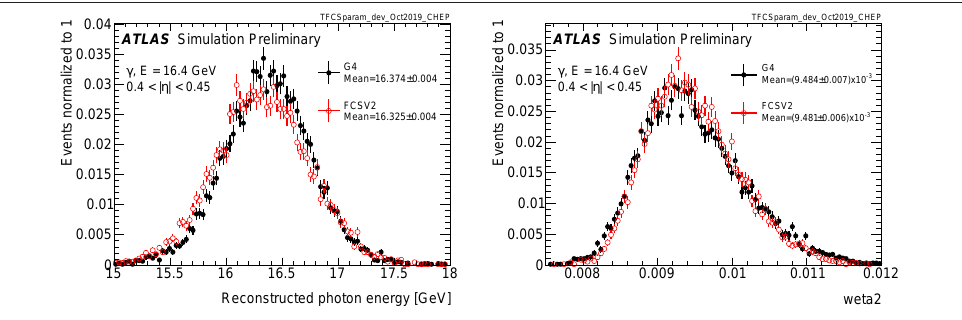
Figure 1. Energy and lateral shower width variable, weta2, for 16 GeV photons with full simulation (G4) and FastCaloSimV2 (FCSV2) [4].